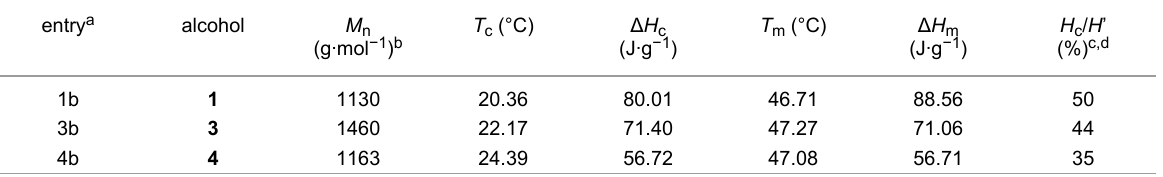
Table 4: DSC data recorded for several polycaprolactones synthesized in this study.